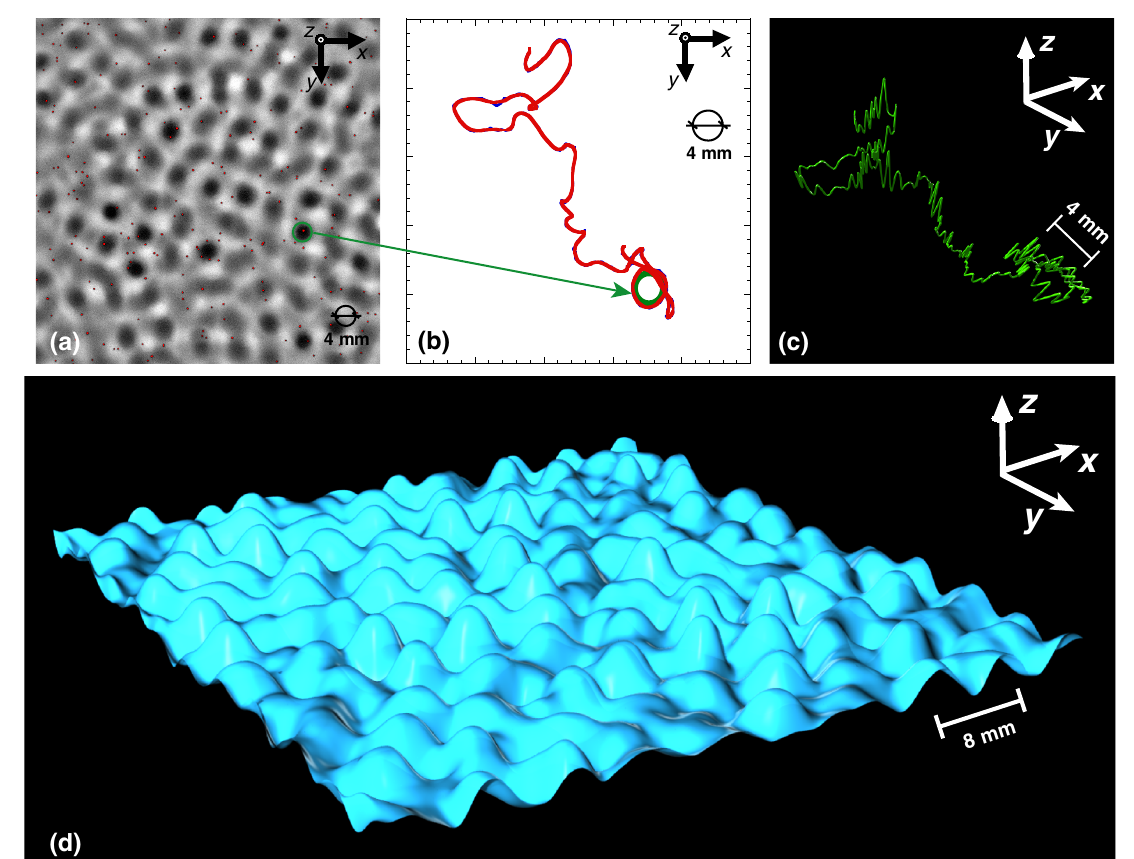
FIG. 8. (a) Diffusing light image of the wave field at a ¼ 2 g ( ϵ ¼ 2 . 3 ) and f 0 ¼ 60 Hz. Dark and light blobs give the location of wave peaks and troughs, respectively. The tiny red dots are tracer particles (diameter of 150 – 300 μ m), the locations of which are extracted from the wave field using a “ rolling ball ” filter. A green circle of radius λ = 4 ¼ 2 mm is indicated. (b) Slight zoom-in view on the horizontal projection of an individual trajectory followed for 4 s at 120 frames per second. This trajectory is reconstructed using a PTV technique. The blue line (barely visible) corresponds to raw data points, the red line is the trajectory smoothed over one Faraday period ( T ¼ 1 =f ≈ 33 ms). (c) 3D reconstruction of the trajectory shown in (b). (d) 3D Visualization of the wave field topography shown in (a). Particles have been removed from the image by using a rolling ball filter, the original image ( 80 × 80 mm 2 ) was smoothed over a 0 . 8 × 0 . 8 mm 2